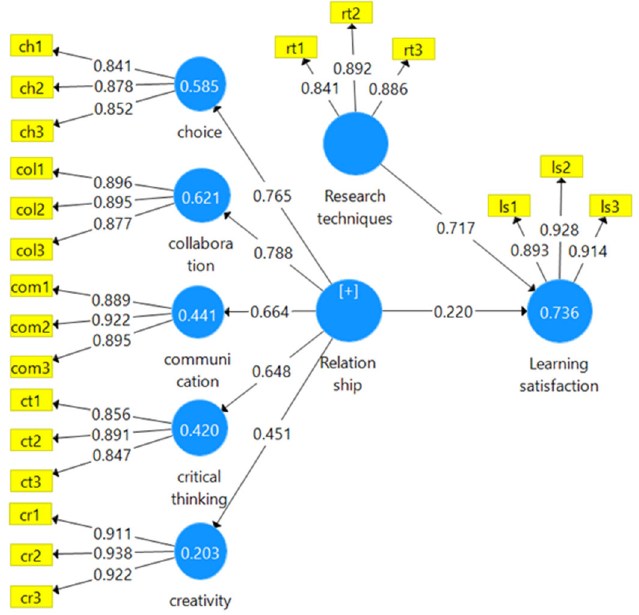
Figure 2. Path (correlation) Coefficient of PLS algorithm. Source: Empirical data analysis by Smart PLS [40].